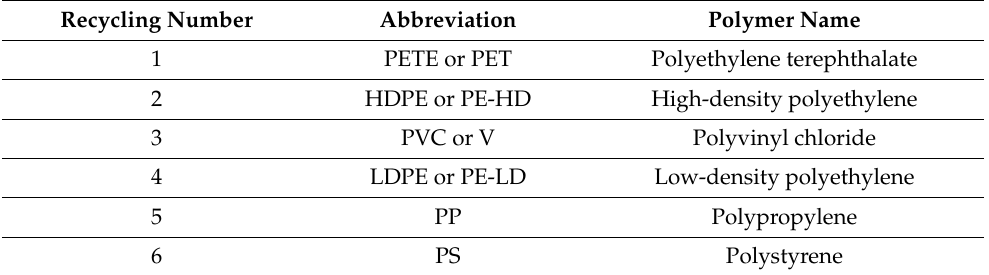
Table 2. Types of polymers used in test case 2 samples.